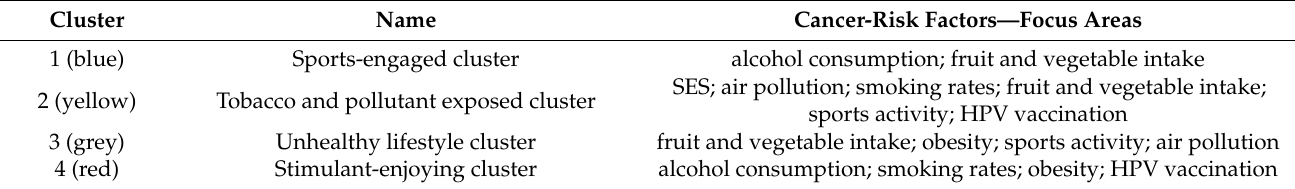
Table 2. Differences among four clusters of EU countries in cancer prevention policy focuses.